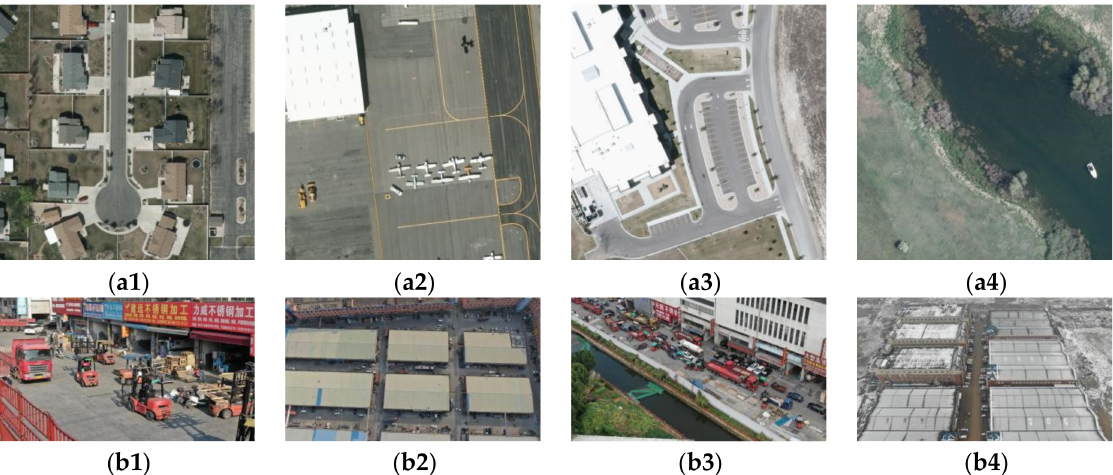
Figure 7. Some examples from the datasets: ( a1 – a4 ) and ( b1 – b4 ) are pictures from the VEDAI and forklift datasets, respectively.